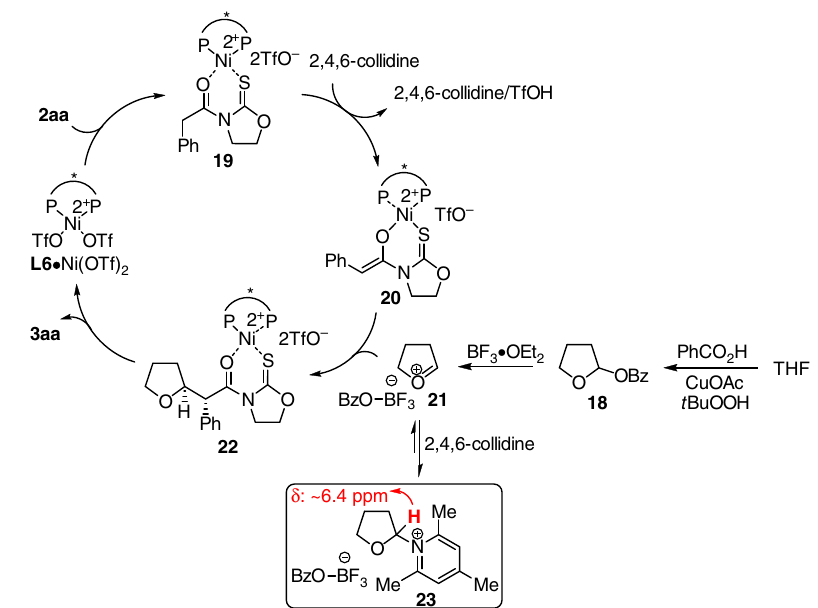
Fig. 7 A proposed catalytic cycle. The possible reaction pathway based on our studies and previous literature